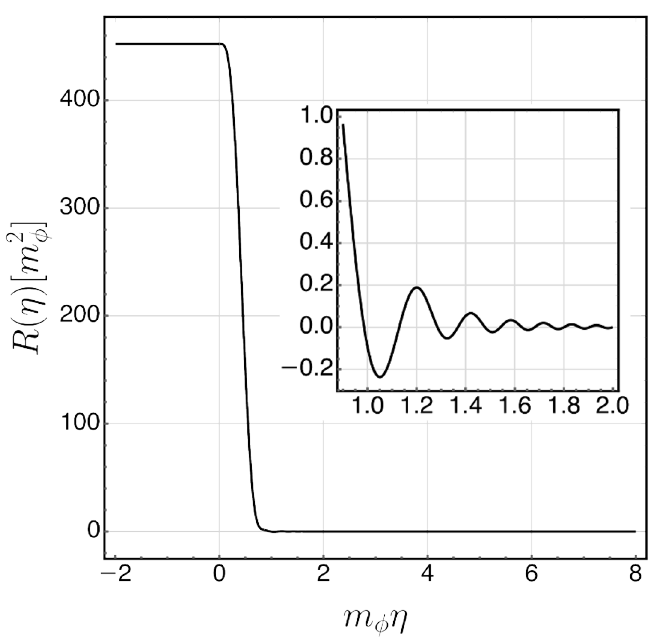
Figure 1 . Curvature scalar R ( (cid:17) ) as a function of conformal time. During de Sitter in(cid:13)ation ( (cid:17) < 0) the Ricci scalar remains constant, which is in good agreement with all the in(cid:13)ationary models. The most appreciable di(cid:11)erence between our approach and a realistic in(cid:13)ationary model should occur near (cid:17) = 0. We have modeled the transition between the end of in(cid:13)ation and the onset of oscillations using a polynomial function so the scalar curvature is a C 4 function. For (cid:17) (cid:21) (cid:17) osc we have considered the curvature sourced by the oscillations of the in(cid:13)aton (cid:12)eld (2.9). equation with elements v and v (cid:3) that only depend on k = j k j . The Fourier mode k k